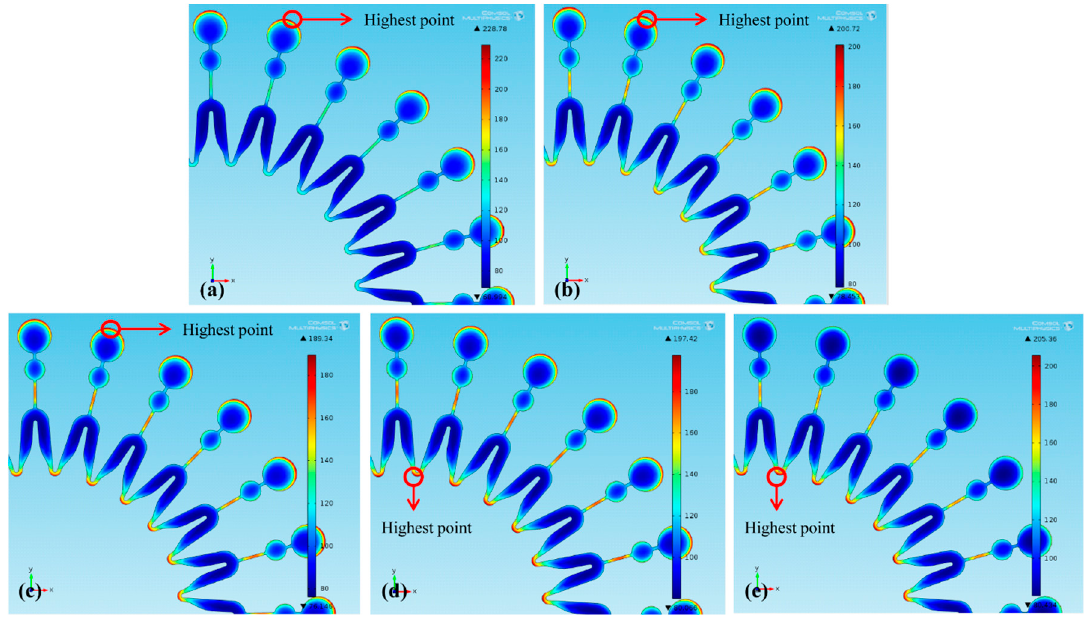
Figure 5. Current density distribution at the mold surface: ( a ) without a second cathode; ( b ) L = 13 mm; ( c ) L = 9 mm; ( d ) L = 5 mm; ( e ) L = 1 mm.